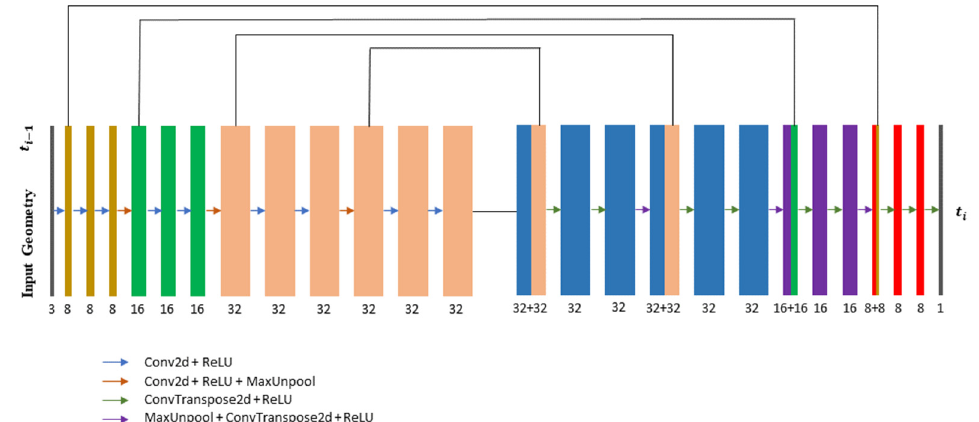
Figure 4. Architecture of the CNN.